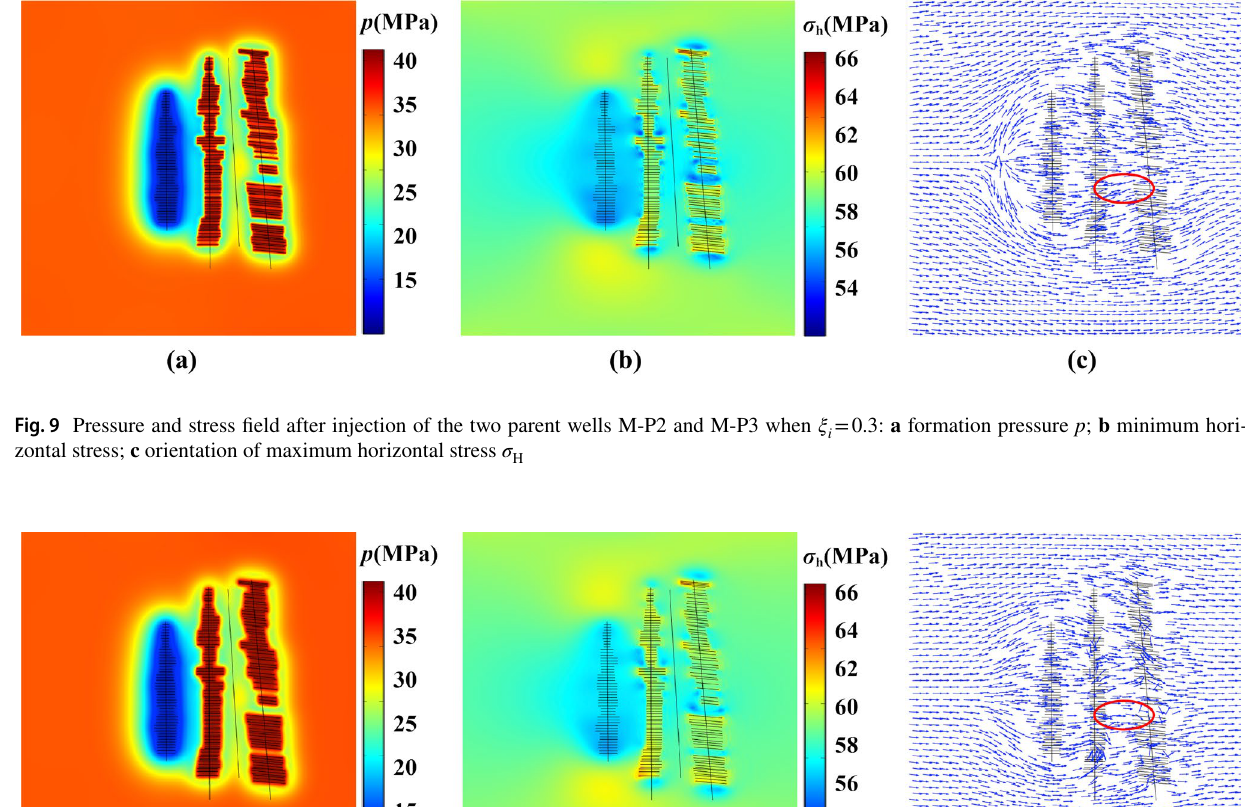
i = 0.5: a formation pressure p ; b minimum hori-